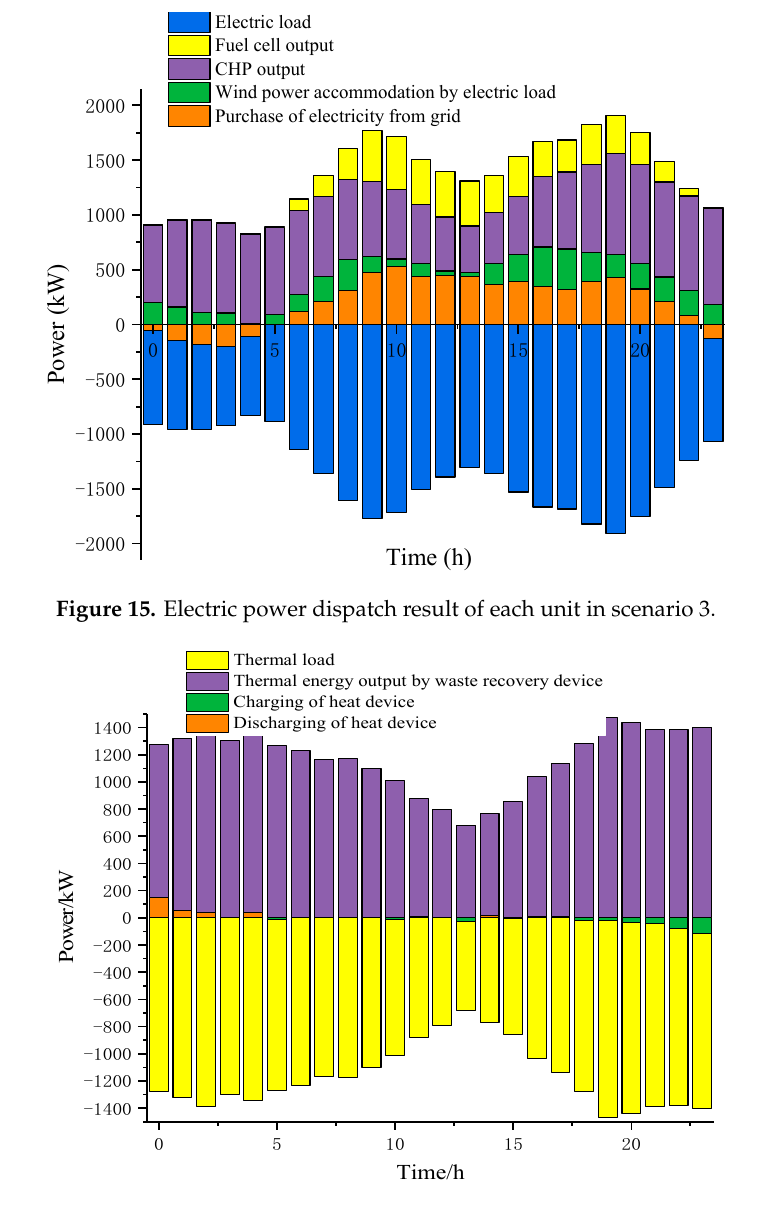
Figure 16. Optimal scheduling of heat power in scenario 3.